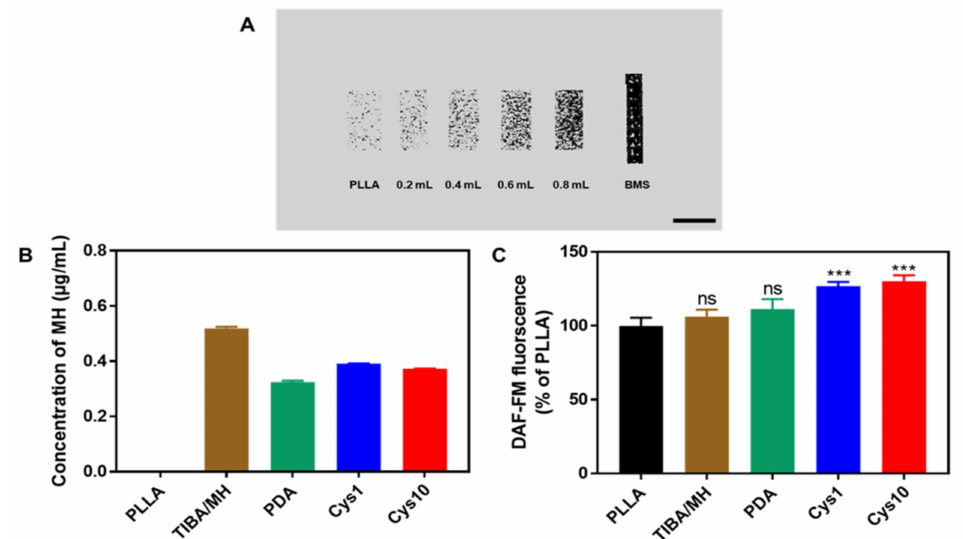
Figure 1. ( A ) X-ray images of PLLA films coated with various concentrations of TIBA; The positive control corresponds to cobalt-chrome BMS (Scale bar = 10 mm), ( B ) ICP-OES for measuring MH contents, and ( C ) DAF-FM fluorescence ratio to PLLA (%) for NO release (*** p < 0.001 vs.